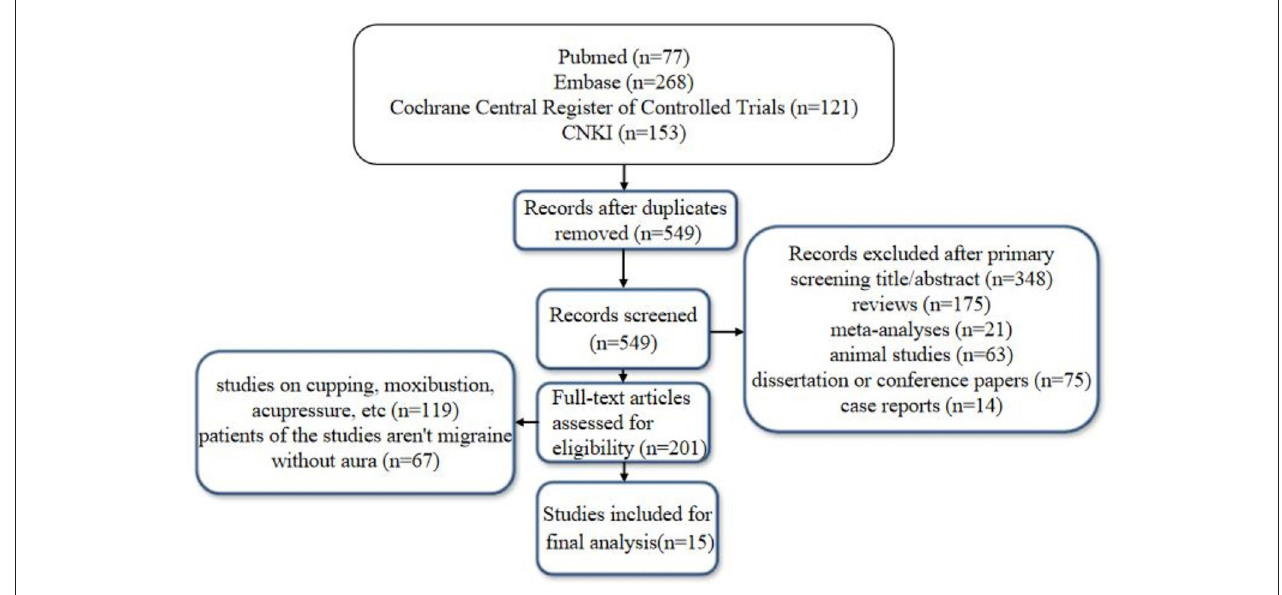
FIGURE 1 | The flow diagram of literature screening.